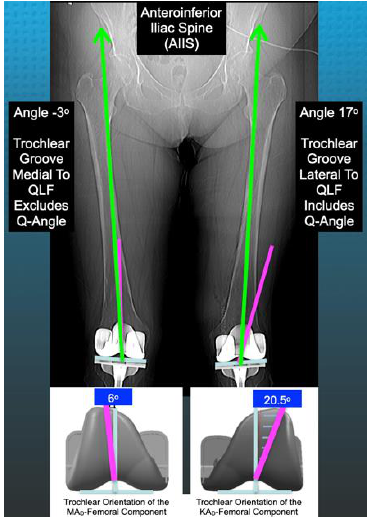
Figure 3. Schematics show the 6° trochlear groove (pink line) of the MA D -FC ( left ) and the 20.5° trochlear groove of the KA D -FC ( right ) evaluated in opposite knees in each patient enrolled in the present study. The angle between the trochlear groove (TG) and the quadriceps line of force (QLF; green line) was measured and defined as TG-QLF. The TG-QLF angle on the scanogram was − 3 ◦ for the MA D -FC ( left ) and 17 ◦ for the KA D -FC ( right ). The distal femoral joint line is defined by the blue line.